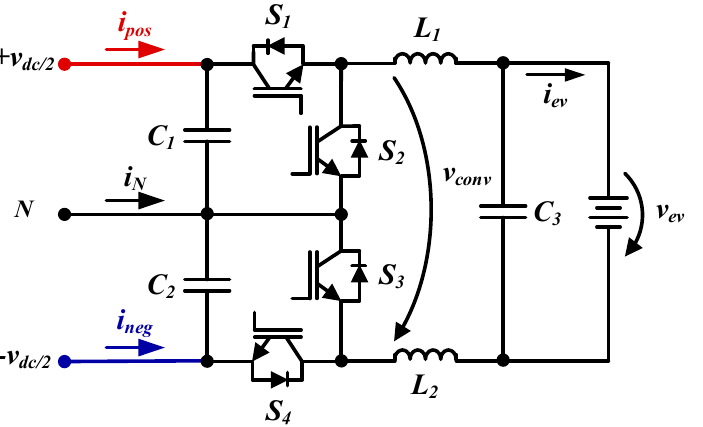
Figure 2. Bidirectional multilevel dc–dc power converter for EV battery charging integrated in a bipolar dc grid.